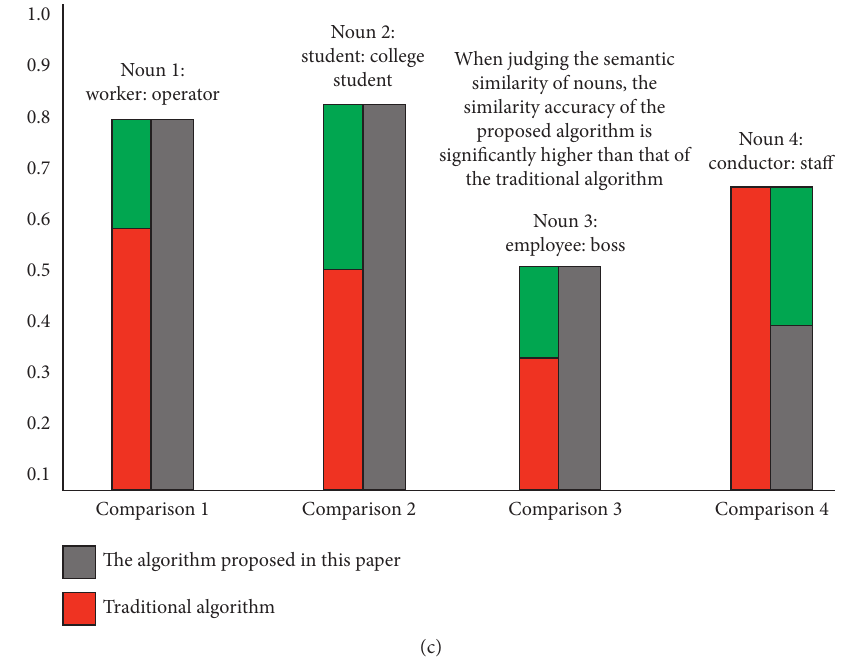
Figure 6: Similarity curve of the algorithm under different vocabulary: (a) verb; (b) adjective; (c) Table 2: Text information similarity comparison results of special data resource description framework types (take similar text as an example).